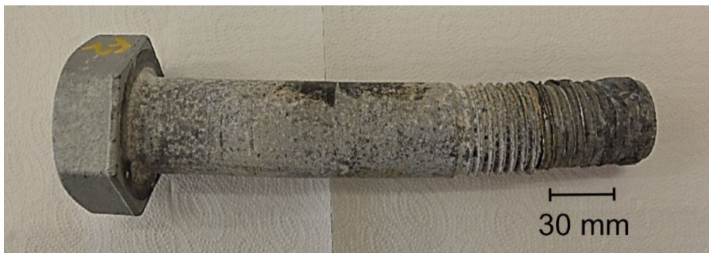
Figure 1. General view of the S1 bolt.